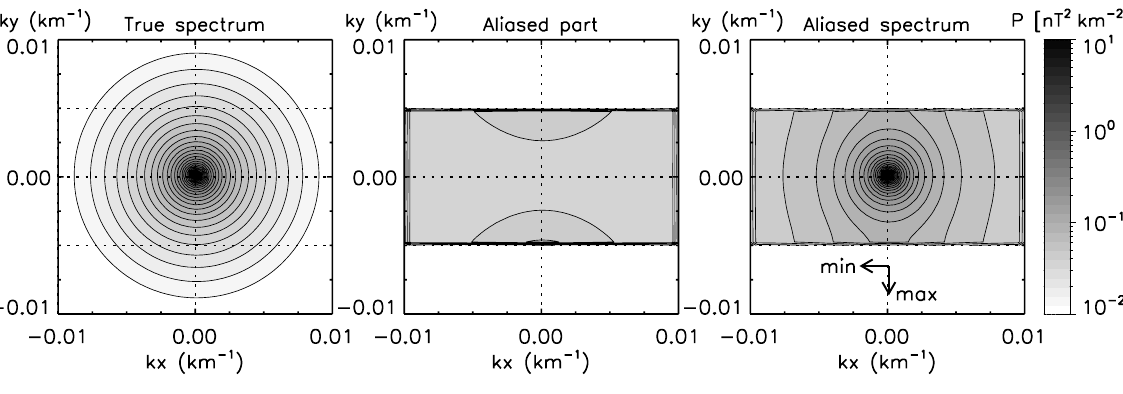
Fig. 4. True spectrum (left), aliased part from the neighboring cells (middle), and aliased spectrum that is a sum of the true spectrum and its aliases (right).